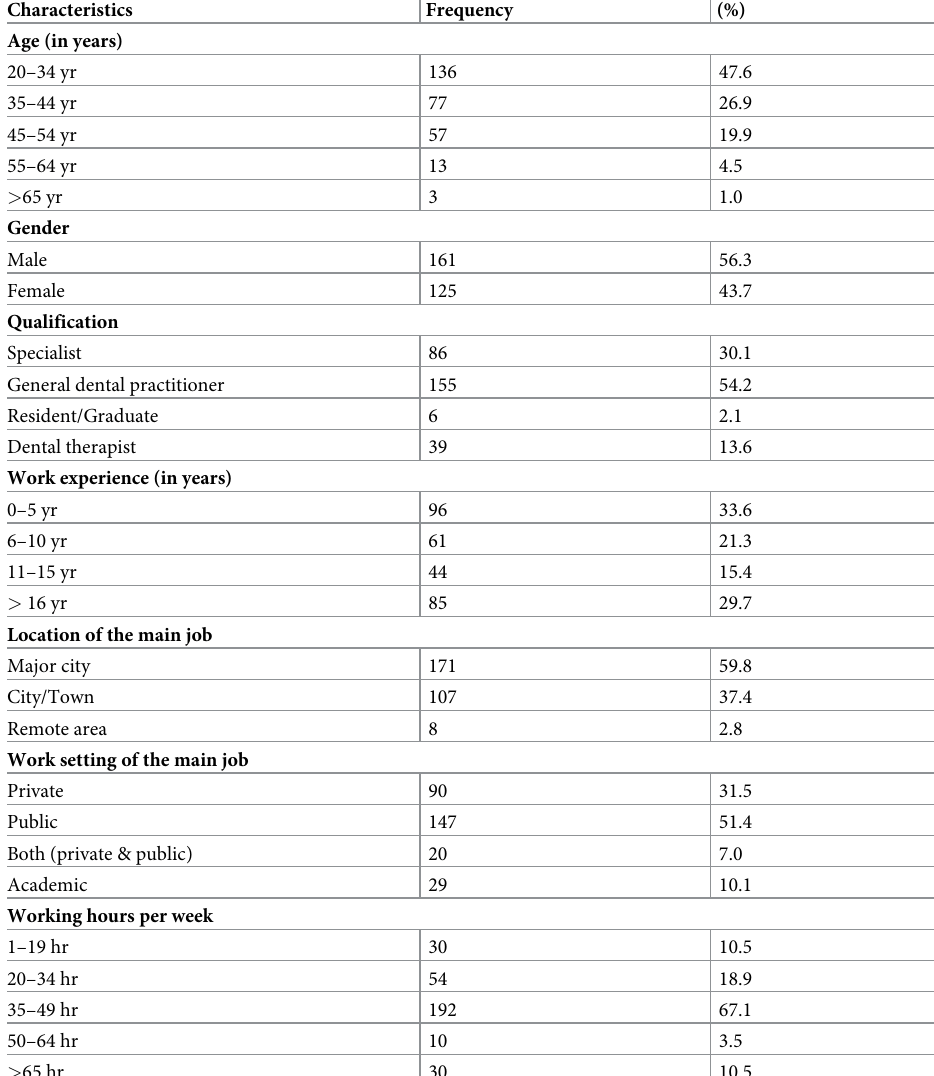
Table 1. Description of demographic and professional characteristics of